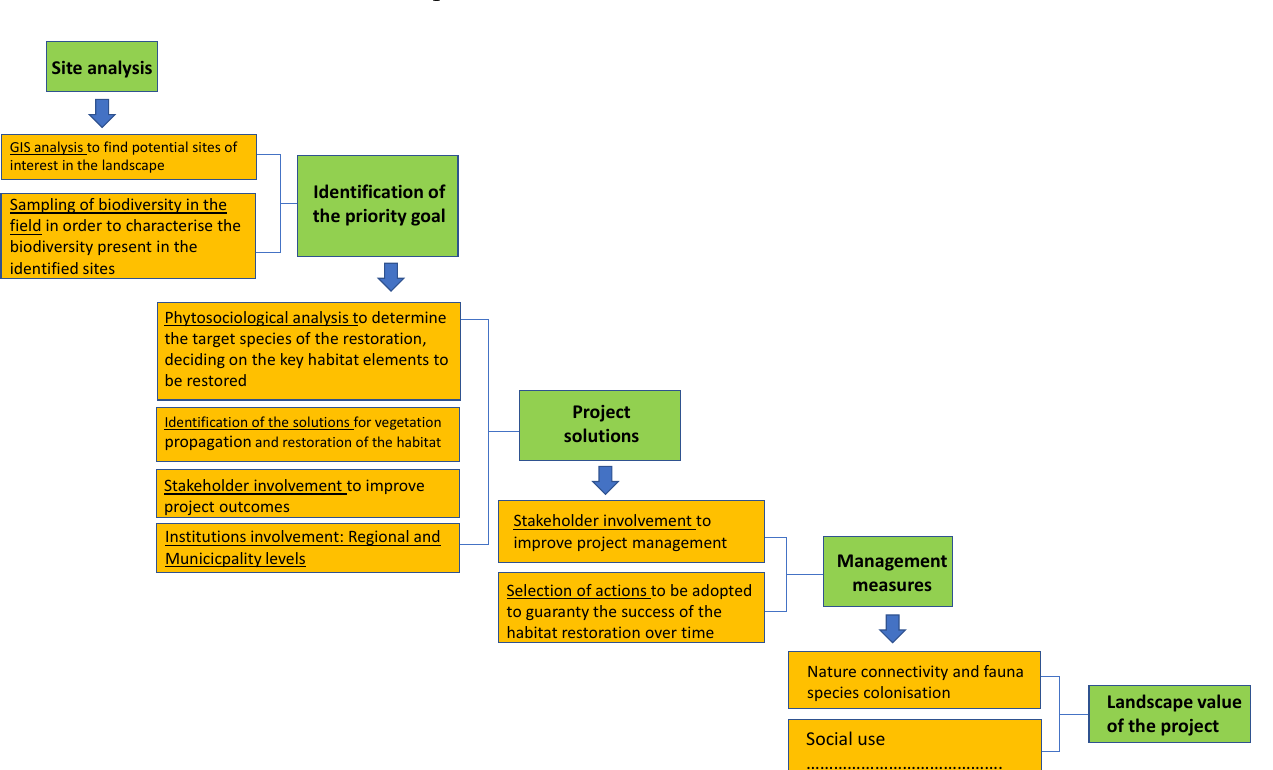
Figure 2. Methodological flowchart of the ecological restoration project realised in the municipality of Campi Salentina.